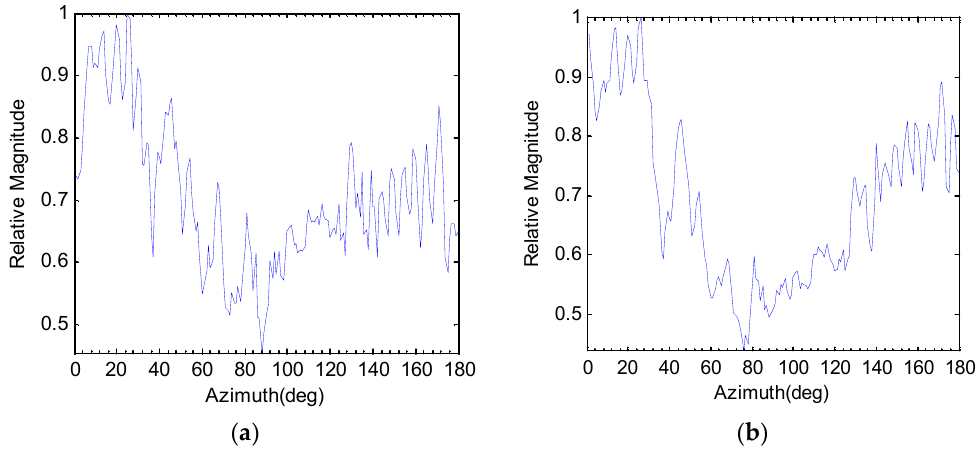
Figure 1. ( a ) Intensity of echo envelope fluctuation after normalization, the frequency is 20–40 kHz and the pulse length is 1 ms; ( b ) STD of echo envelope fluctuation after normalization.